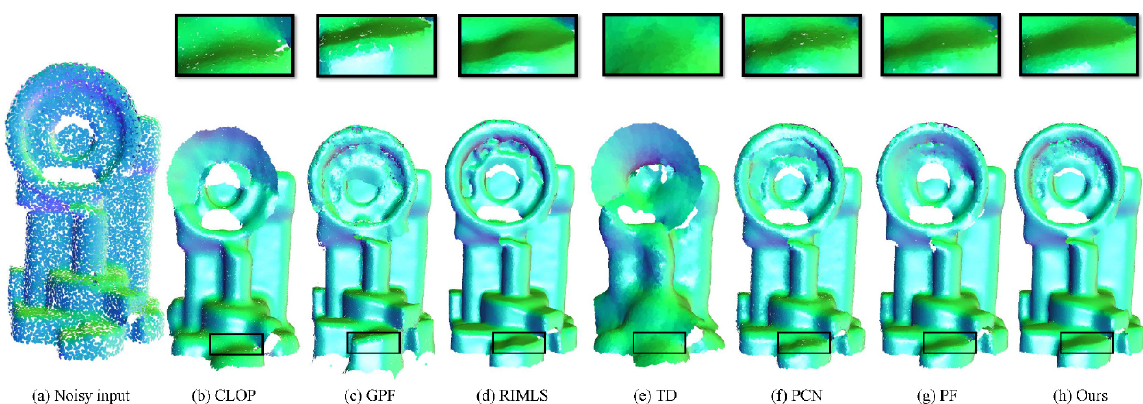
Fig. 10 Results on BuddhaStele raw scanned model. Above: corresponding upsampling results. Below: reconstructed meshes.